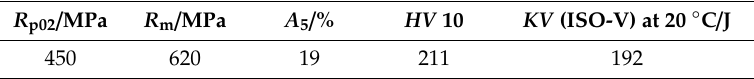
Table 2. Mechanical properties of the P91